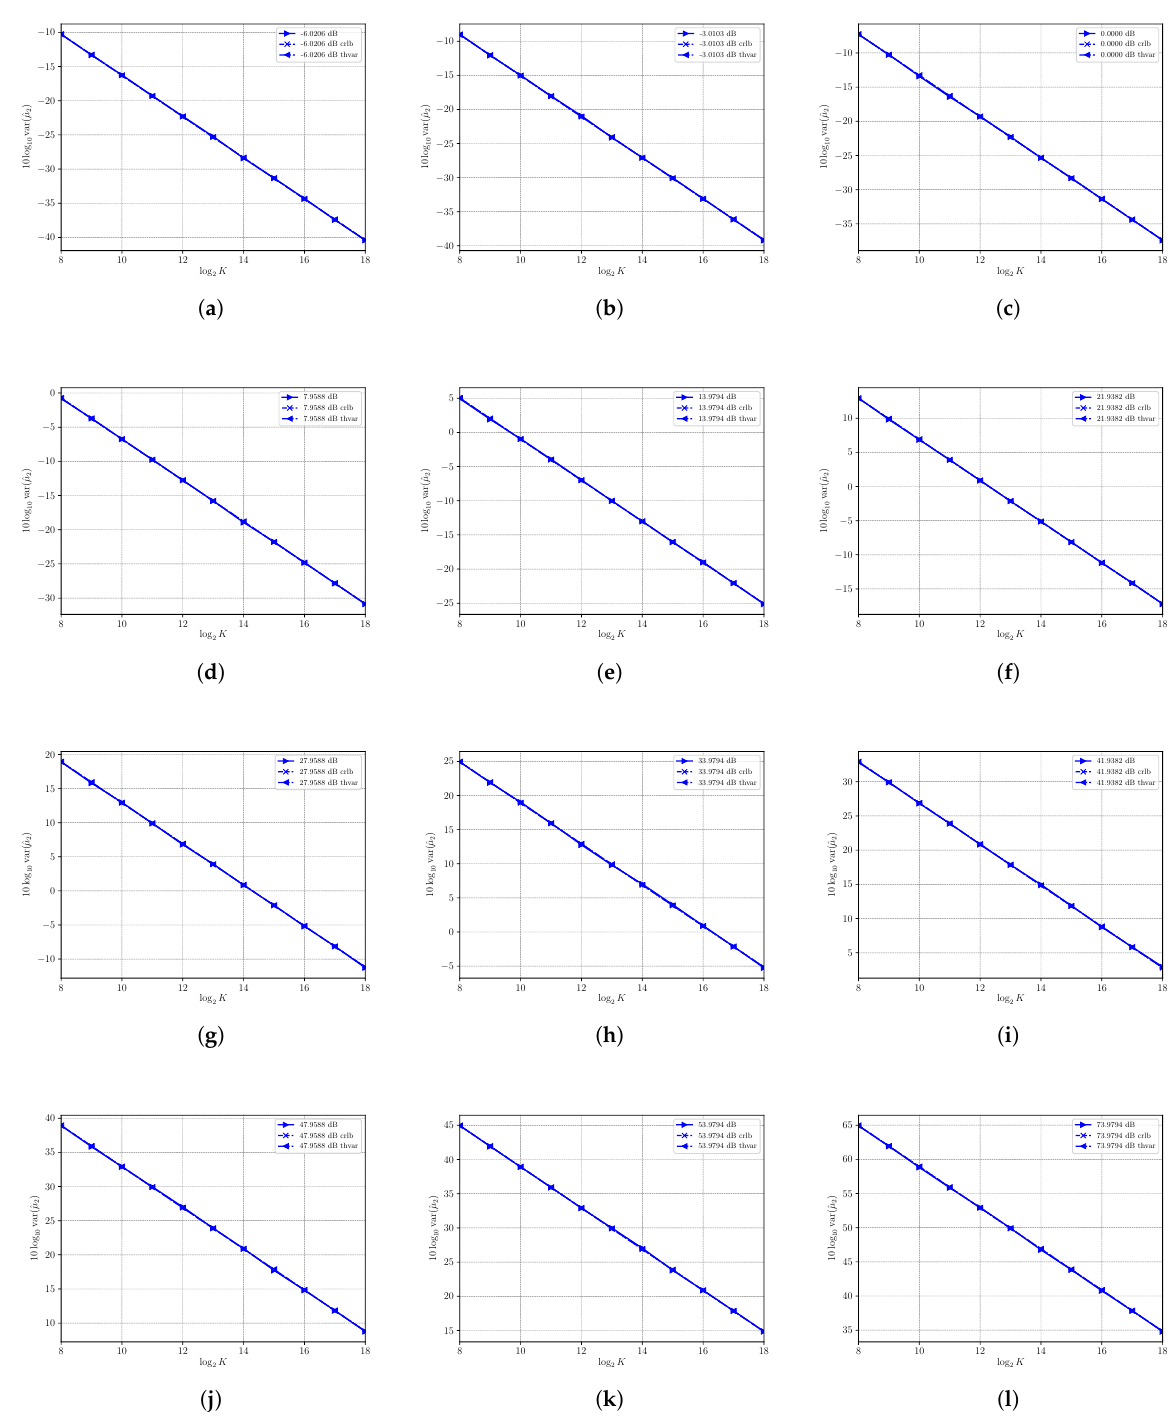
Figure 1. Asymptotic and estimated variances of the moment estimator ˆ µ 2 versus the number of observations K . Each sub figure ( a – l ) shows results for a given nominal value of SNR obtained by changing the signal power S and with noise power N =